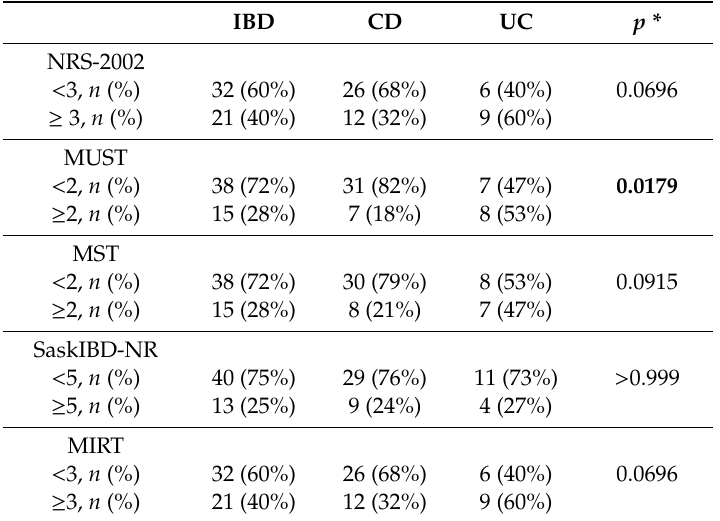
Table 6. Prevalence of high nutritional risk according to di ff erent screening tools. IBD CD UC p *